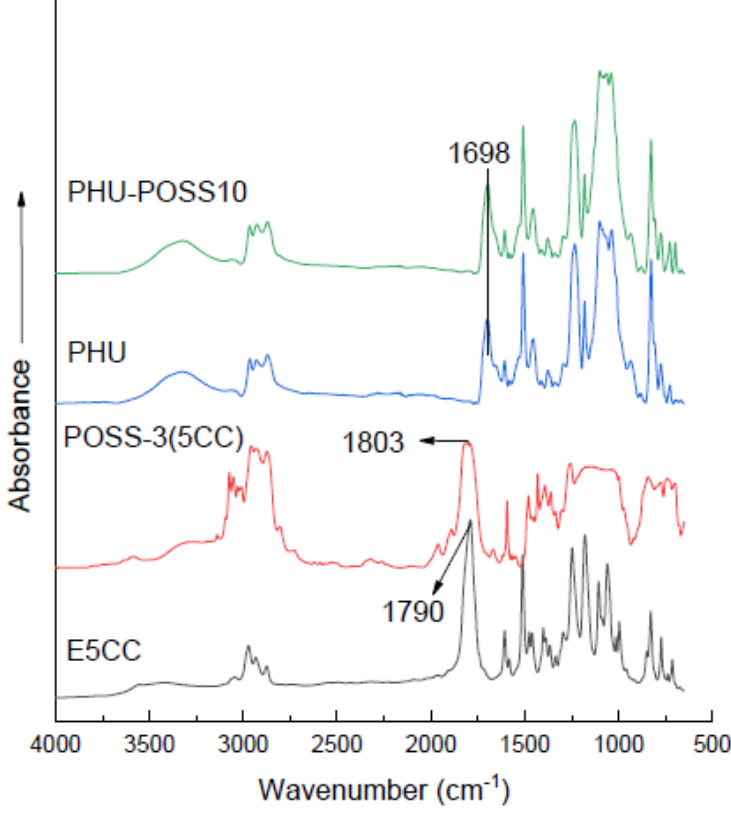
Figure 3. FTIR spectra of DE5CC, POSS-3(5CC), PHU, and PHU-POSS10 nanocomposite. slightly lower than the theoretical values.